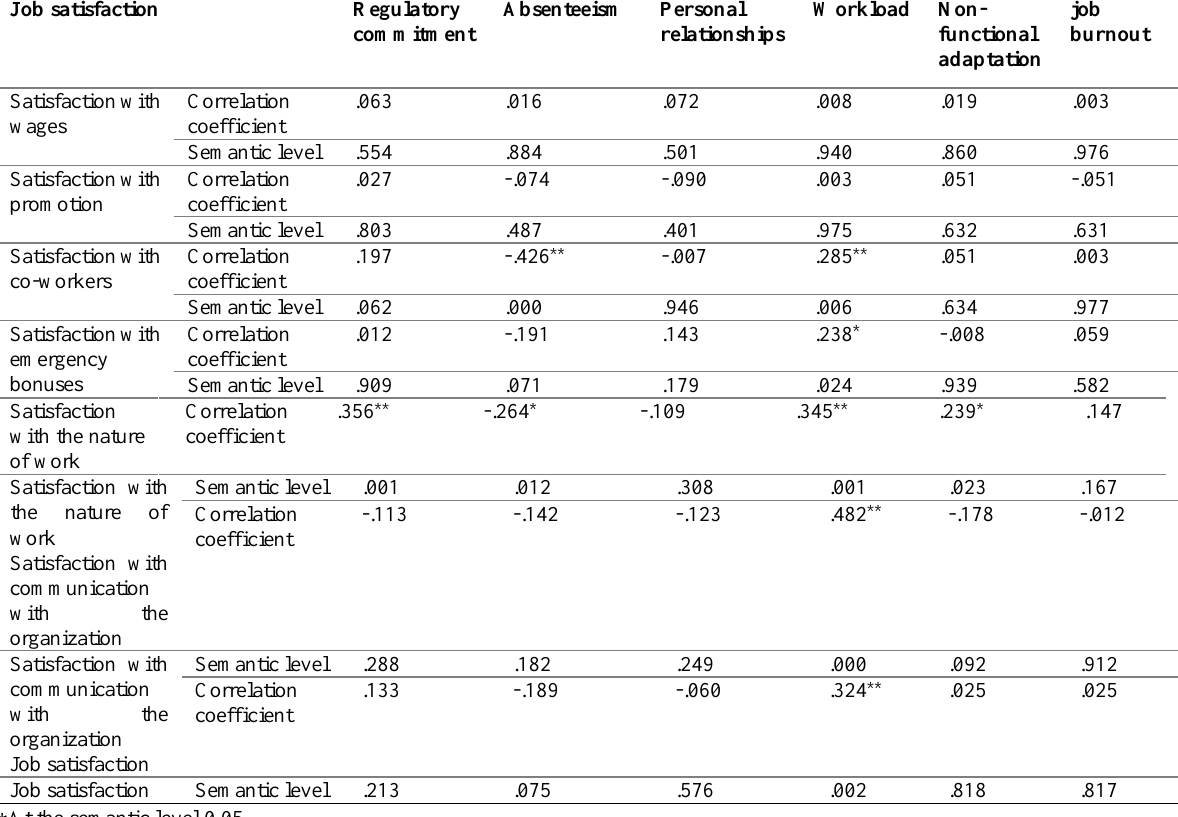
Table 2: Pearson correlation coefficient between job satisfaction and job burnout